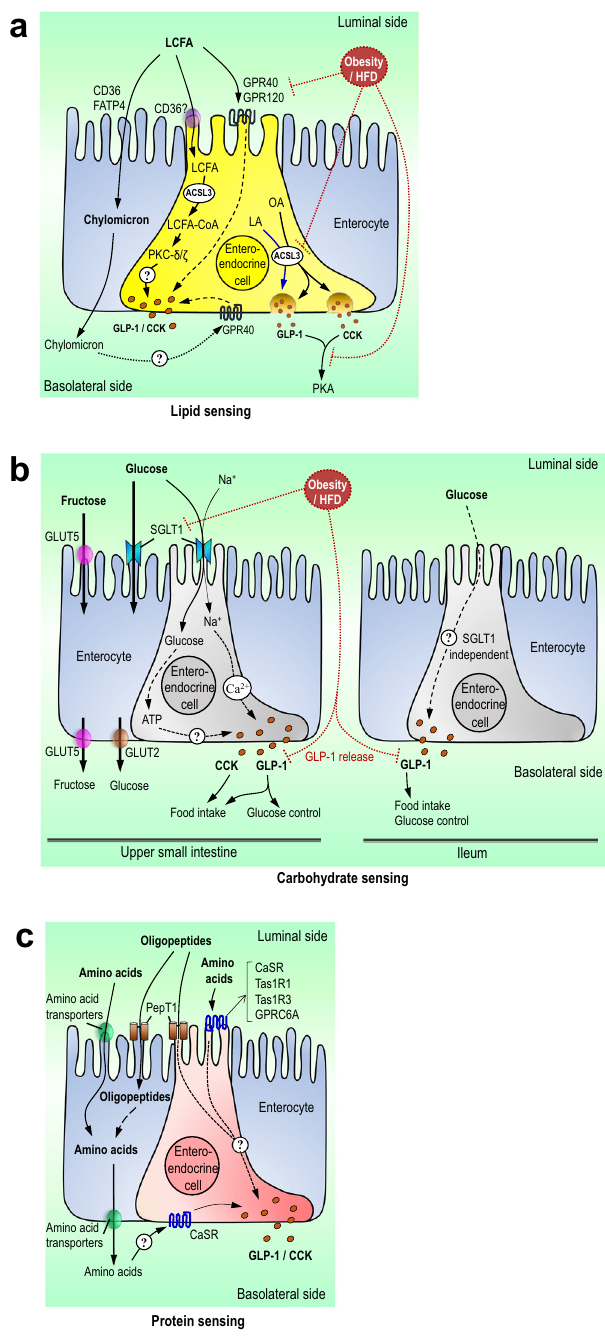
Fig. 2 Mechanisms of small intestinal nutrient sensing. a Mechanisms of small intestinal lipid sensing. Small intestinal long-chain fatty acids are taken up (via CD36/FATP4 and/or simple diffusion) by enterocytes to form triglycerides and eventually packaged into chylomicrons released on the basolateral side. LCFA are also taken up by enteroendocrine cells to undergo ACSL3-dependent metabolism and activate PKCs to